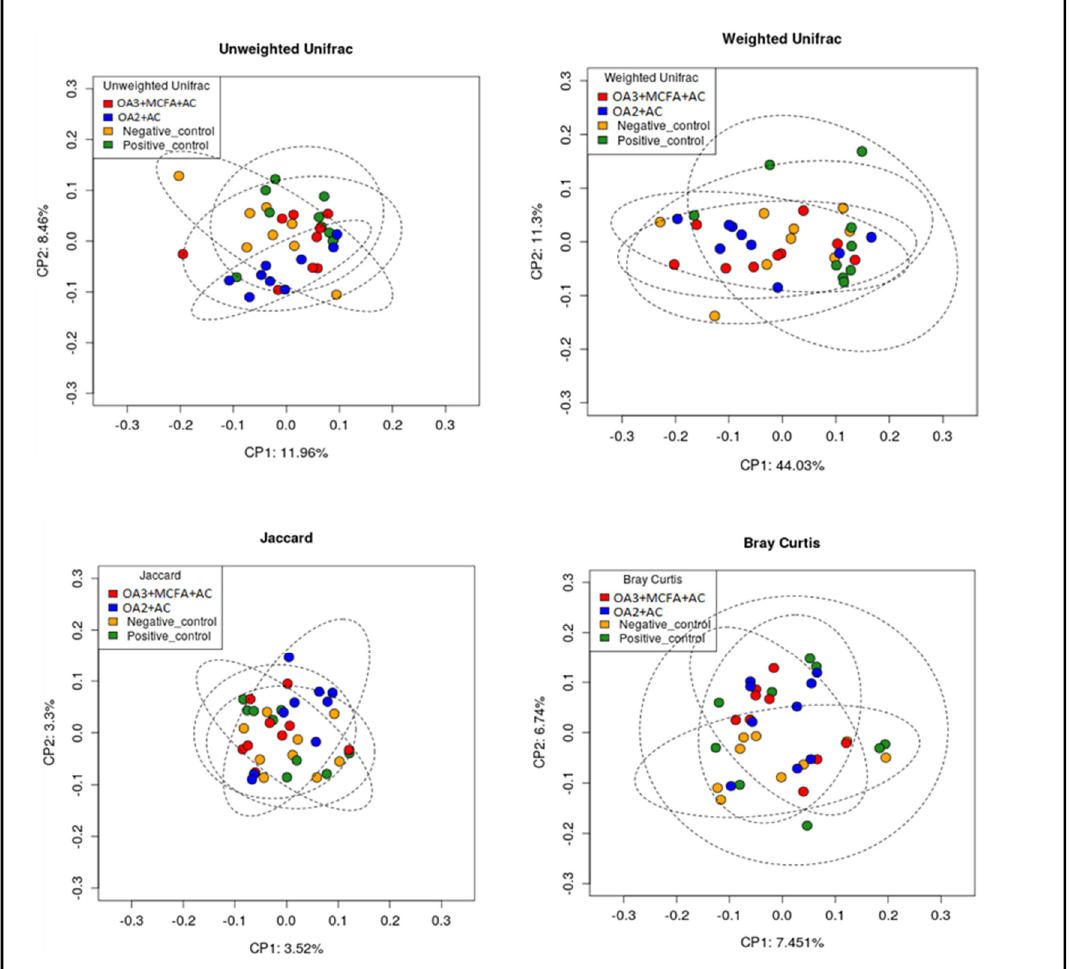
Figure 6. Effect of different dietary treatments on bacterial beta diversity on cecum of broilers on d 42 (Trial 2). (OA2: Calcium butyrate + fumaric acid; OA3: Calcium butyrate + fumaric acid + citric acid + MCFA; MCFA: Capric-caprylic acid + caproic acid + lauric acid; AC: Cinnamaldehyde, carvacrol, and thymol as major compounds).